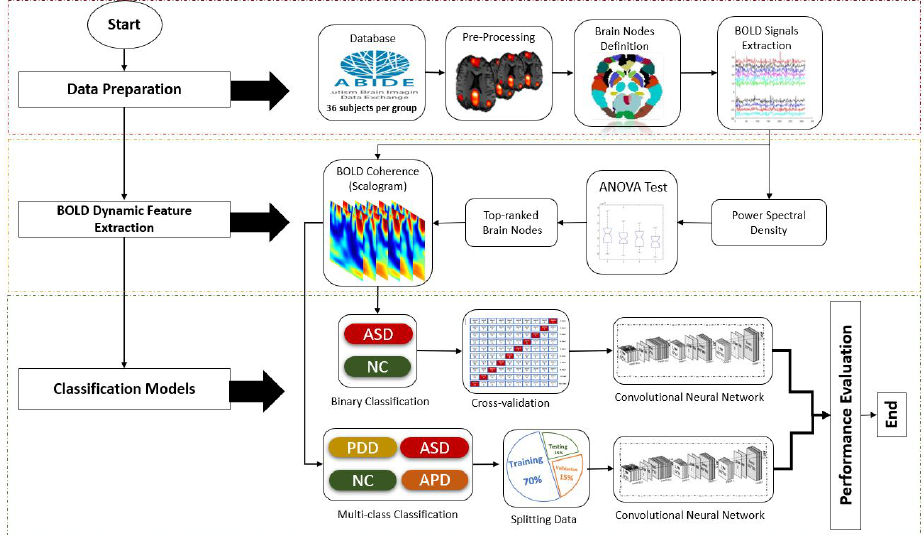
Figure 1. Methods for development of binary and multi-class classification of BOLD fMRI signals using wavelet coherence and CNN.